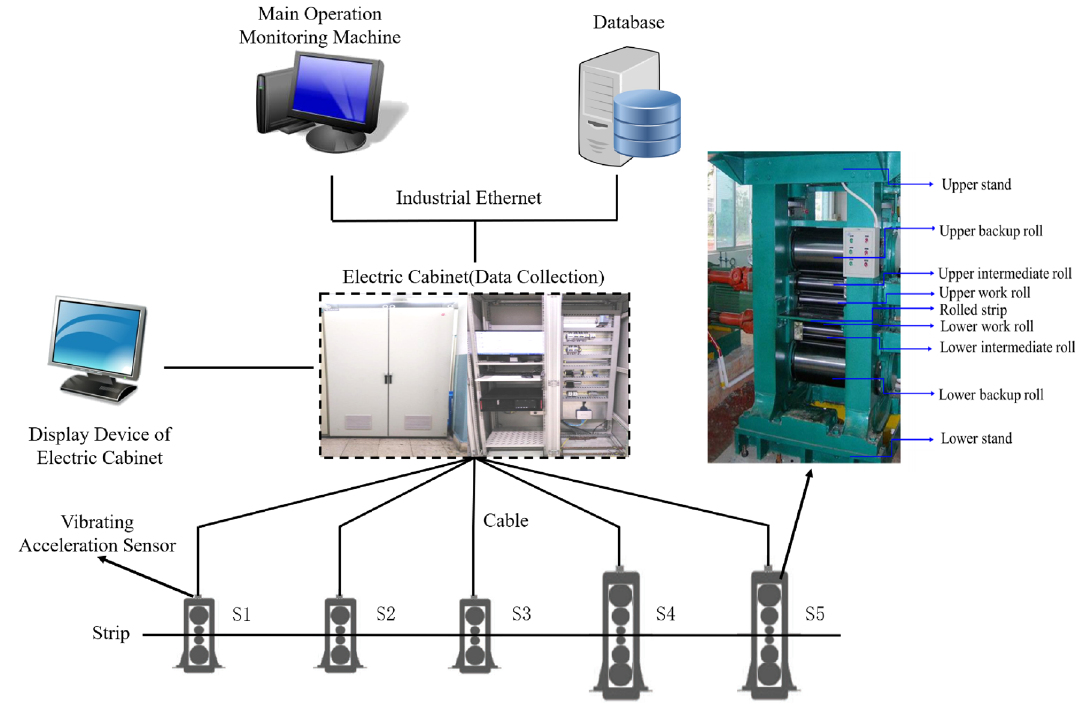
Fig. 1 Vibration online monitoring